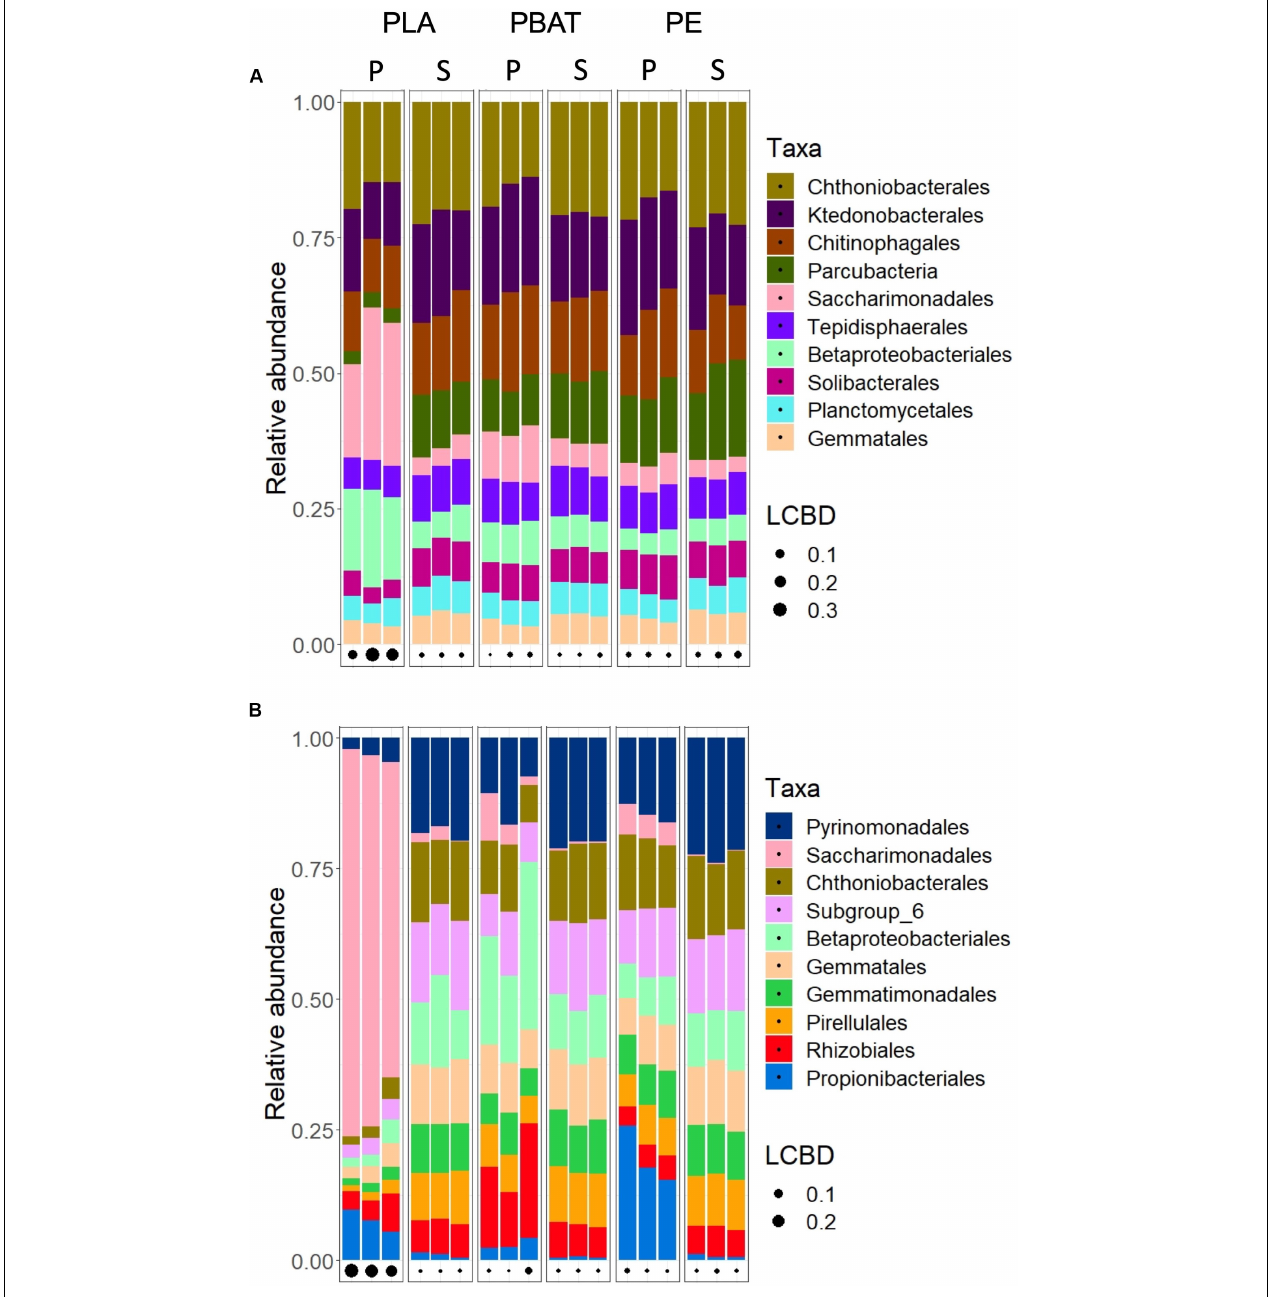
FIGURE 4 | Relative abundance of the ten most abundant bacterial orders in the plastisphere (P) and bulk soil (S) of Barba Peider (Swiss Alps) (A) and Villum (Northern Greenland) (B) soils. The three replicates for each habitat are shown as separate columns. LCBD, local contribution to β